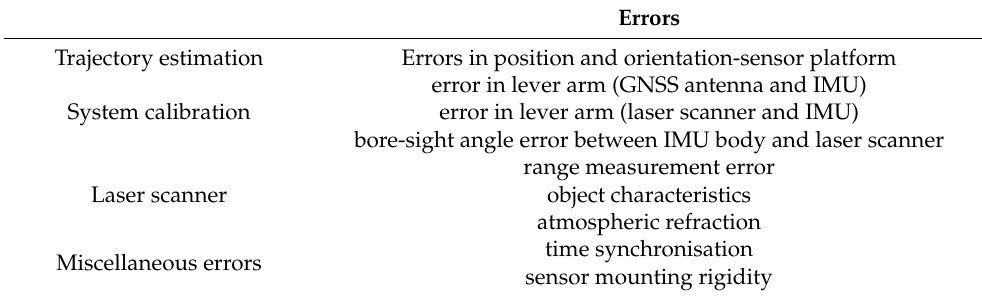
Table 1. Major error sources for UAV-based laser scanning systems (refer to